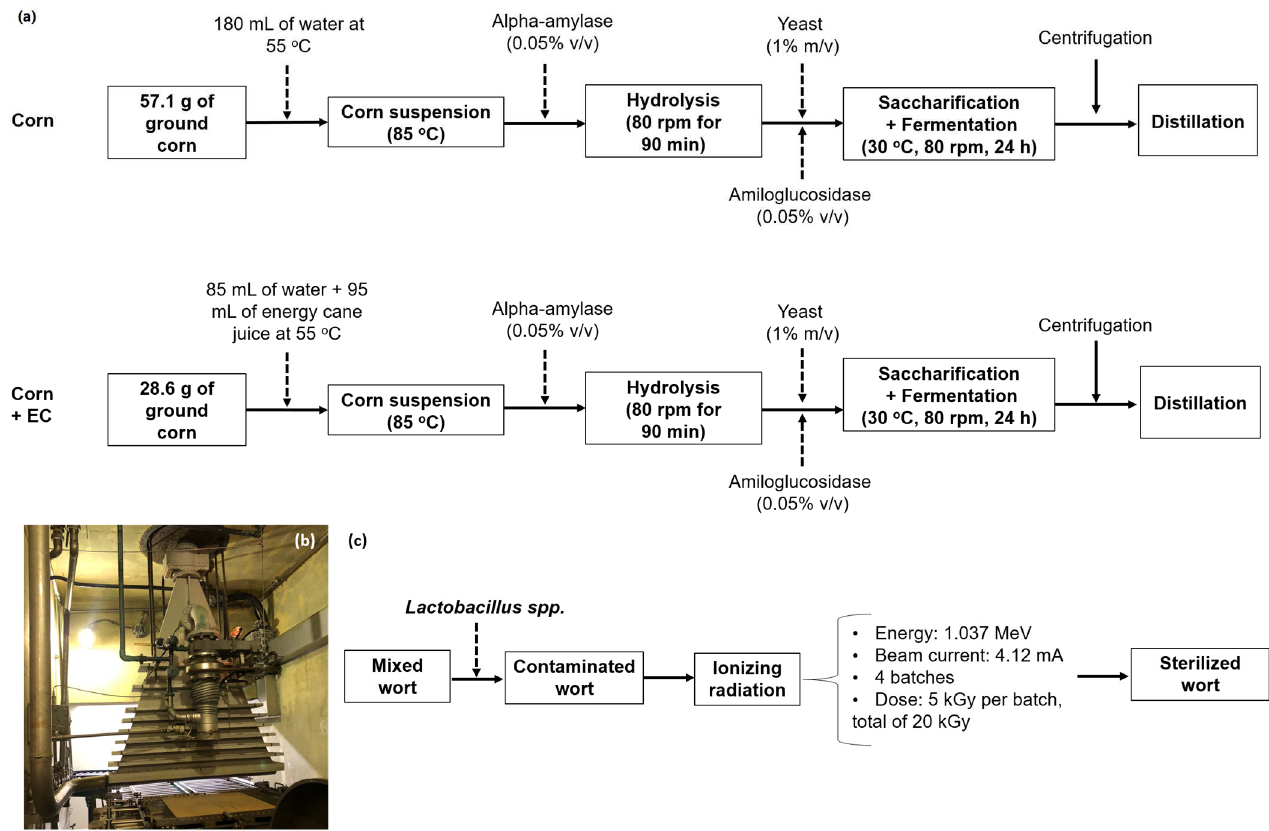
Figure 1. ( a ) Diagram demonstrating the processes used for both treatments used in study one (only corn and mixture of corn and energy cane as sources of carbohydrates for yest fermentation). ( b ) Industrial electron accelerator used in this study (Dynamitron—Job 188, model DC 1500/25/4) manufactured by RDIRadiation Dynamics Incorporation ® . ( c ) Diagram with the steps done for the sterilization of mixed wort in this study. Table 1. Composition of the energy cane juice used in Study 1.